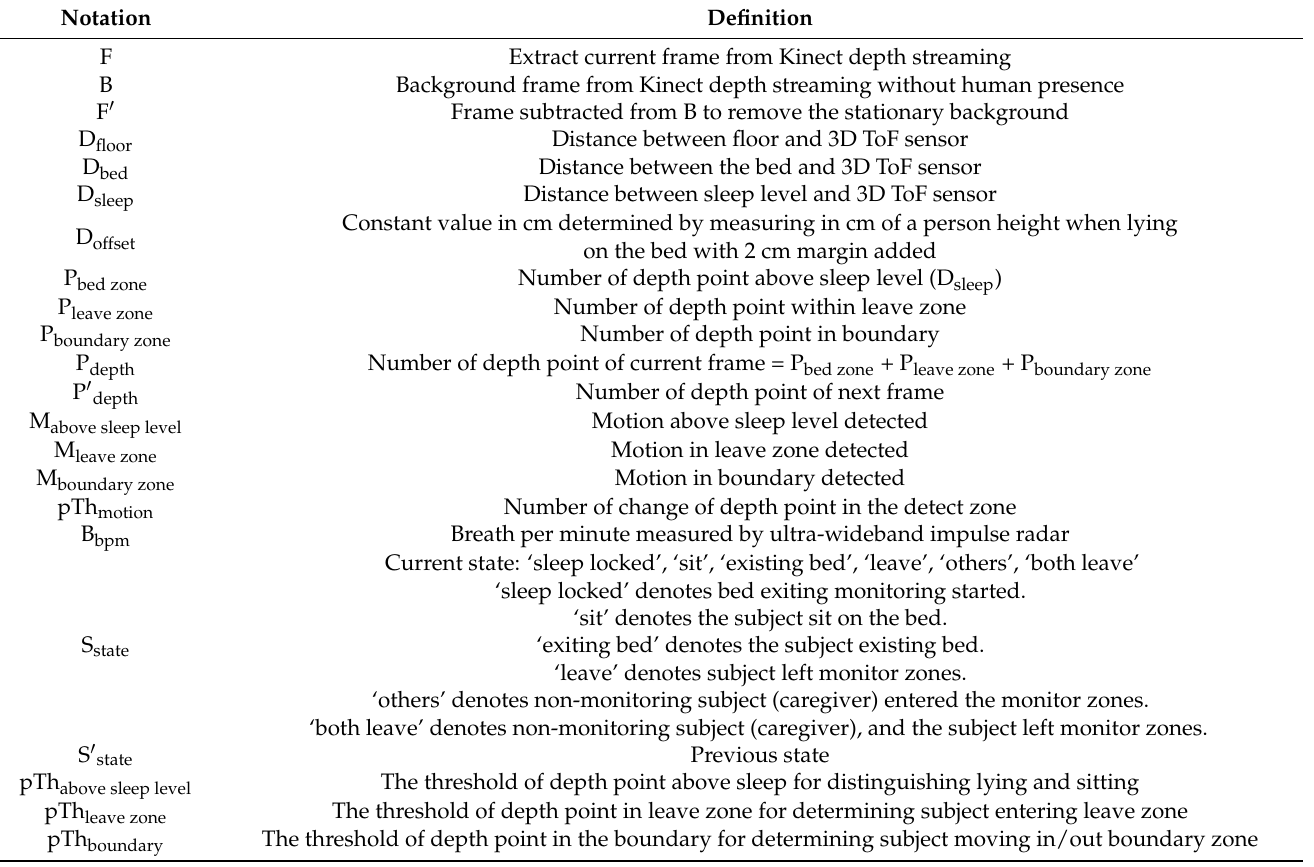
Table 1. List of notations and definitions used in the algorithm of eNightLog